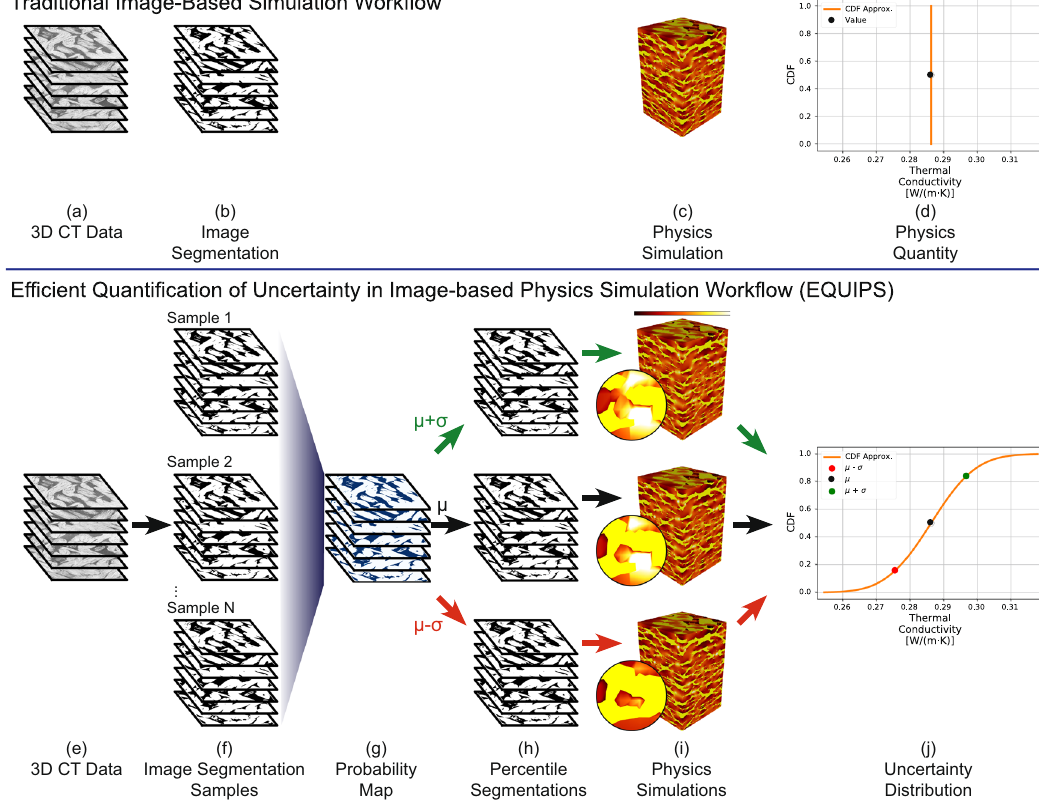
Fig. 2 Traditional image-based simulation work fl ow (top) versus proposed ef fi cient quanti fi cation of uncertainty in image-based physics simulation (EQUIPS) work fl ow (bottom). A traditional image-based simulation work fl ow (top) converts 3D images ( a ) into image segmentations ( b ) using manual or CNN-based algorithms, then performs a numerical simulation on the reconstructed segmented image domain ( c ) to calculate a deterministic physics quantity ( d ). In EQUIPS (bottom), segmentation uncertainty is calculated from 3D images ( e ) by creating many image segmentation samples ( f ) and combining them into a probability map ( g ). The probability map is thresholded at different percentile values to construct percentile segmentation domains ( h ), each of which are used to perform physics simulations ( i ) whose output is combined into an uncertainty distribution ( j ), represented as a cumulative distribution function (CDF) for that physics quantity. The colors in ( i ) show localized heat fl ux in a thermal conductivity simulation on a relative (arbitrary) color simulations on the exemplar of a woven composite material (Fig. 2). We train a BCNN to segment 3D grayscale CT images (Fig. 2e). The output of the network is a softmax layer that, when thresholded at 0.5, creates a binary representation of voxels that are inside the segmented class. Next, we Monte Carlo sample the network to generate N unique image segmentation samples (Fig. 2f). Each image segmentation sample represents a valid inference through the model, with each sample probing the image and model uncertainty stochastically.